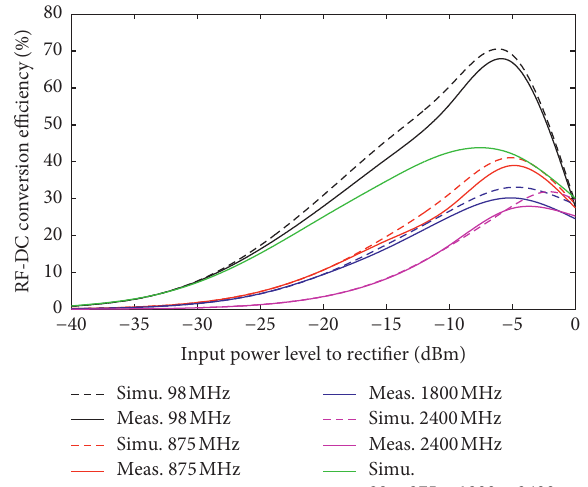
Figure 31: RF-DC conversion efficiency of the integrated multiband rectifier for 10k Ω load.